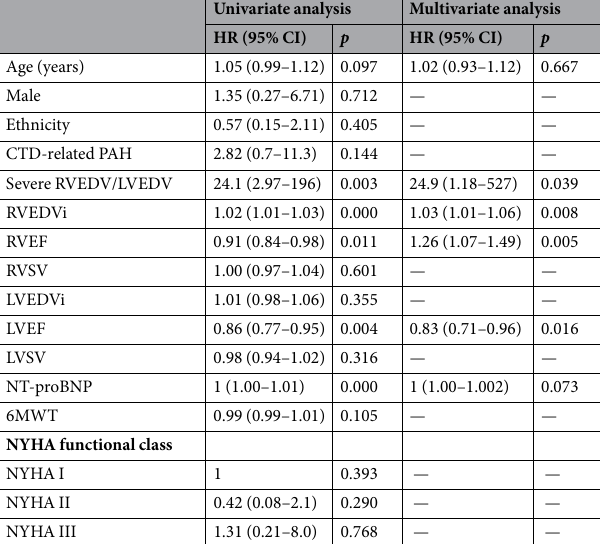
Table 3. Cox regression analysis for prediction of all-cause mortality. CTD, connective tissue disease; PAH, pulmonary artery hypertension; RVEDVi, right ventricular end-diastolic volume index; RVEF, right ventricular ejection fraction; RVSV, right ventricular stroke volume; LVEDVi, left ventricular end-diastolic volume index; LVEF, left ventricular ejection fraction; LVSV, left ventricular stroke volume; 6MWT, six-minute walk test; -,